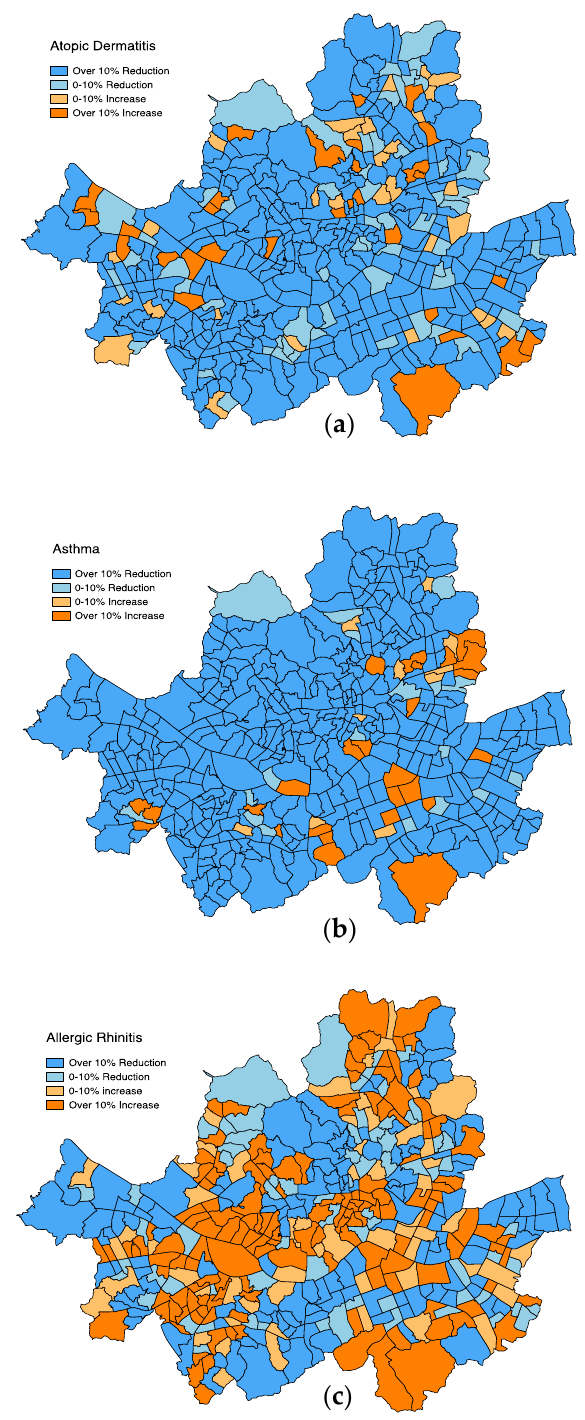
Figure 2. Changes in allergic disease prevalence at 423 sub-districts in Seoul (2011–2015): ( a ) atopic dermatitis; ( b ) asthma; ( c ) allergic rhinitis.